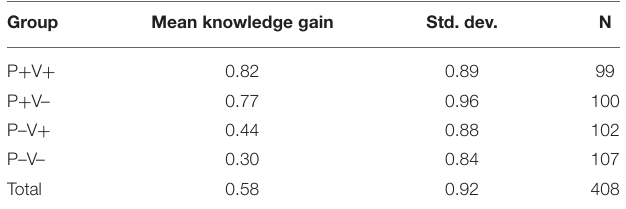
TABLE 3 | Average knowledge gain by group. Group Mean knowledge gain Std. dev.